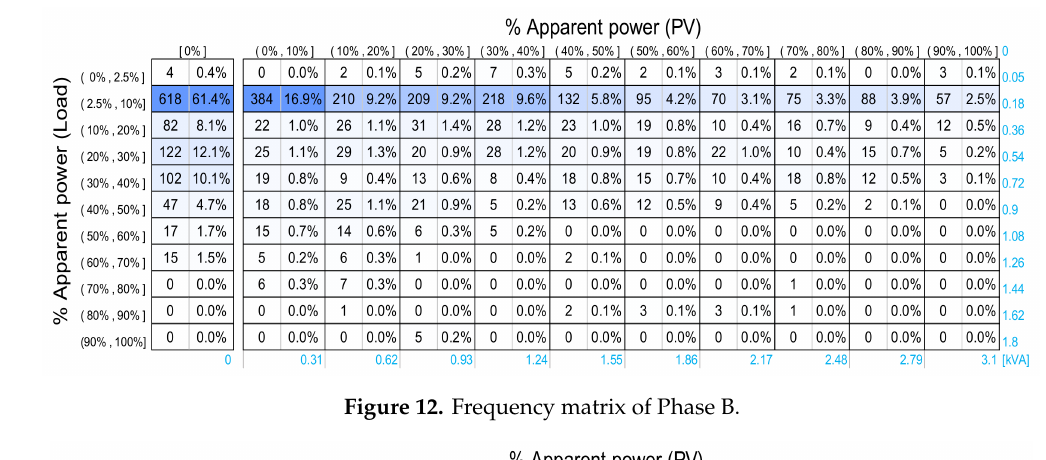
Figure 11. Frequency matrix of Phase A.